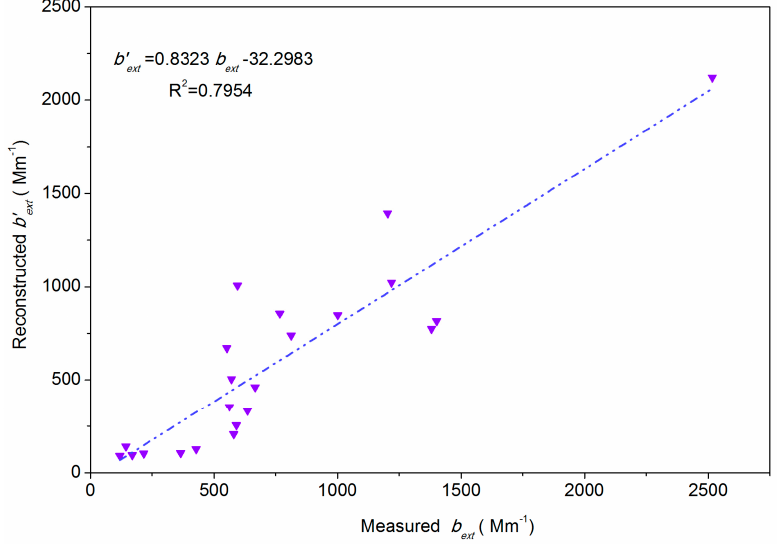
Figure 4. The reconstructed extinction coefficient ( b ext ) and the measured extinction coefficient ( b ′ ext ) in Beijing during the sampling period in 2016.